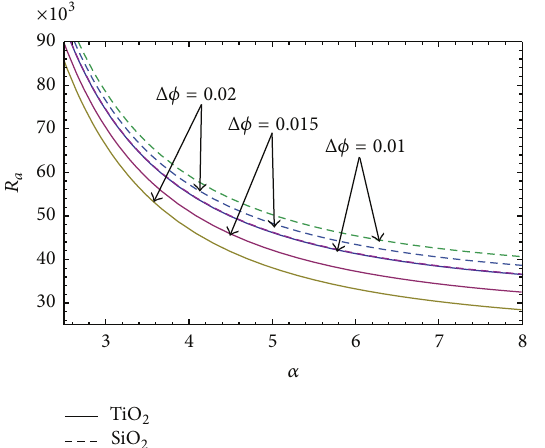
Figure 8: Effect of Δ𝜙 on semiconducting nanoparticles.